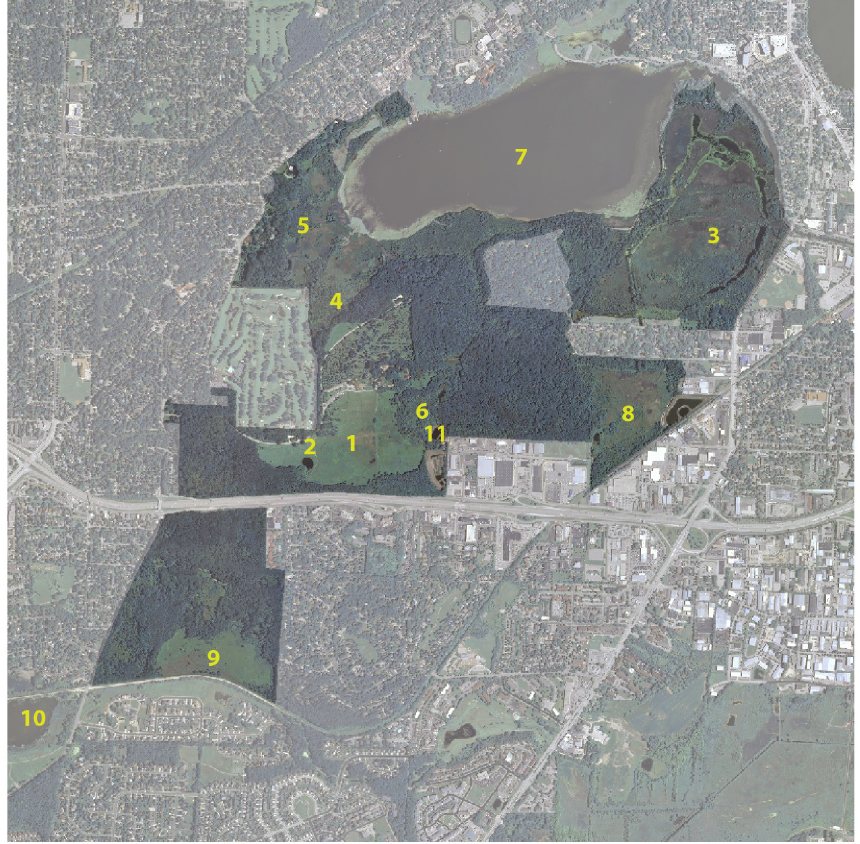
Figure 1. The UW-Madison Arboretum (485 ha) is surrounded by urban watersheds,